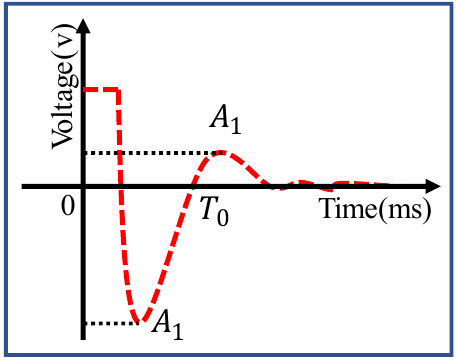
Figure 18. A typical attenuation curve in the DC excitation method.